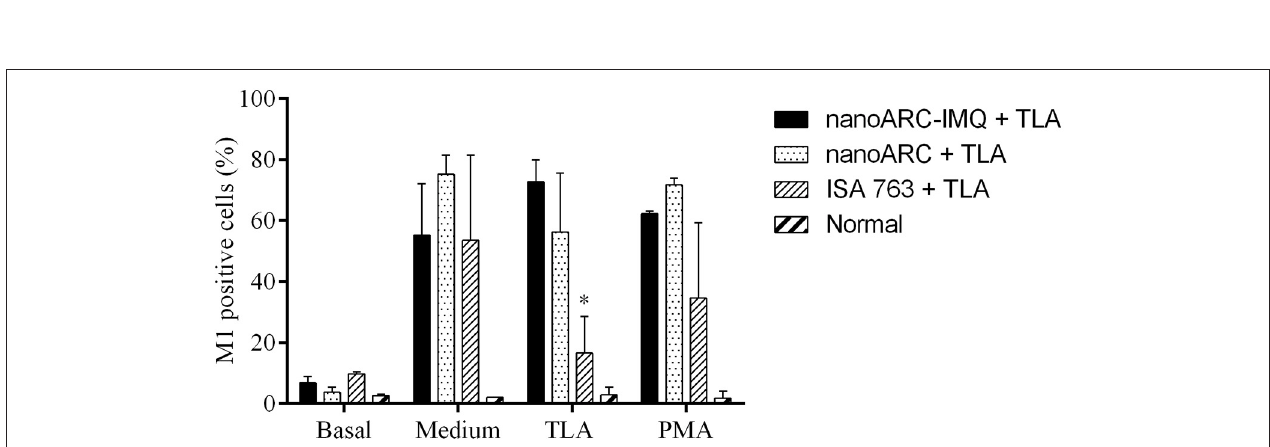
FIGURE 9 | Lymphoproliferation assay. Each sample was examined by triplicate and each bar is the media ± SD of 2 mice per group. Asterisk indicates significant differences between cells stimulated respect to the control with culture media.